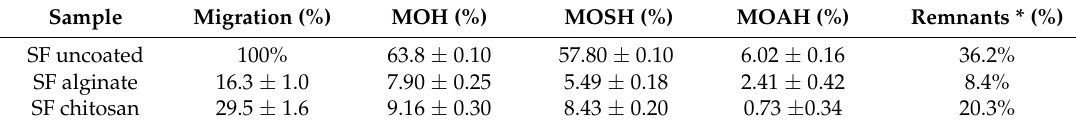
Table 4. Overall migration of mineral oil hydrocarbons (MOH), mineral oil saturated hydrocarbons and mineral oil aromatic hydrocarbons (MOSH/MOAH), in uncoated and coated paper samples from primary fiber (PF) and secondary fiber (SF) (%, n =